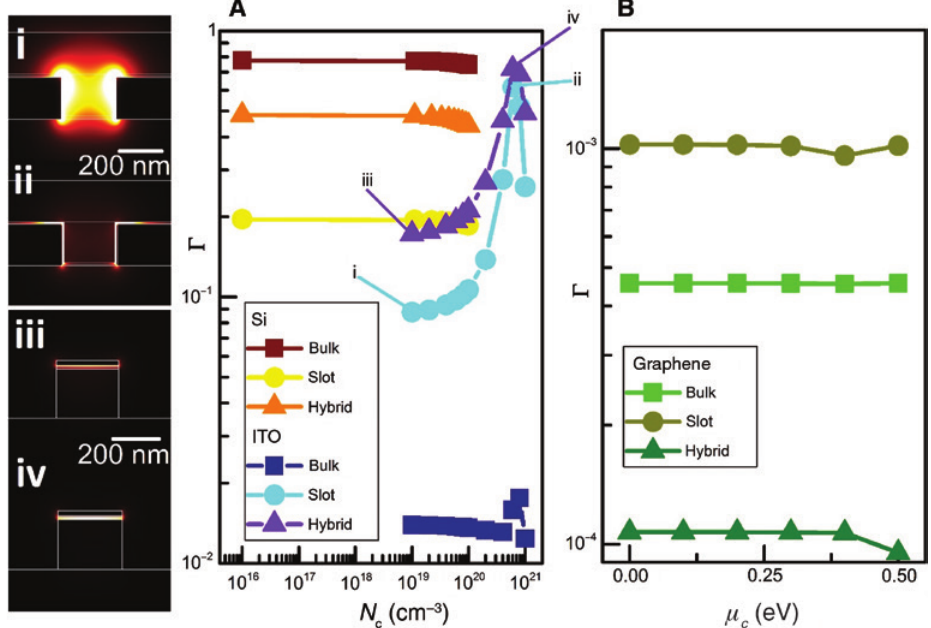
Figure 3: Confinement factors of the modes from Figure 2 with tuning. Confinement factors corresponding to the Si and ITO modes vs. carrier concentration (A) and confinement factors corresponding to the graphene modes vs. chemical potential (B). (i, ii) ITO slot at 10 19 cm −3 and 6 × 10 20 cm −3 , (iii, iv) ITO hybrid at 10 19 cm −3 and 6 × 10 20 cm −3 ,